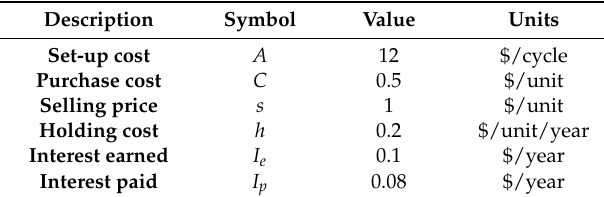
Table 3. Numerical data from the Teng [10] model.